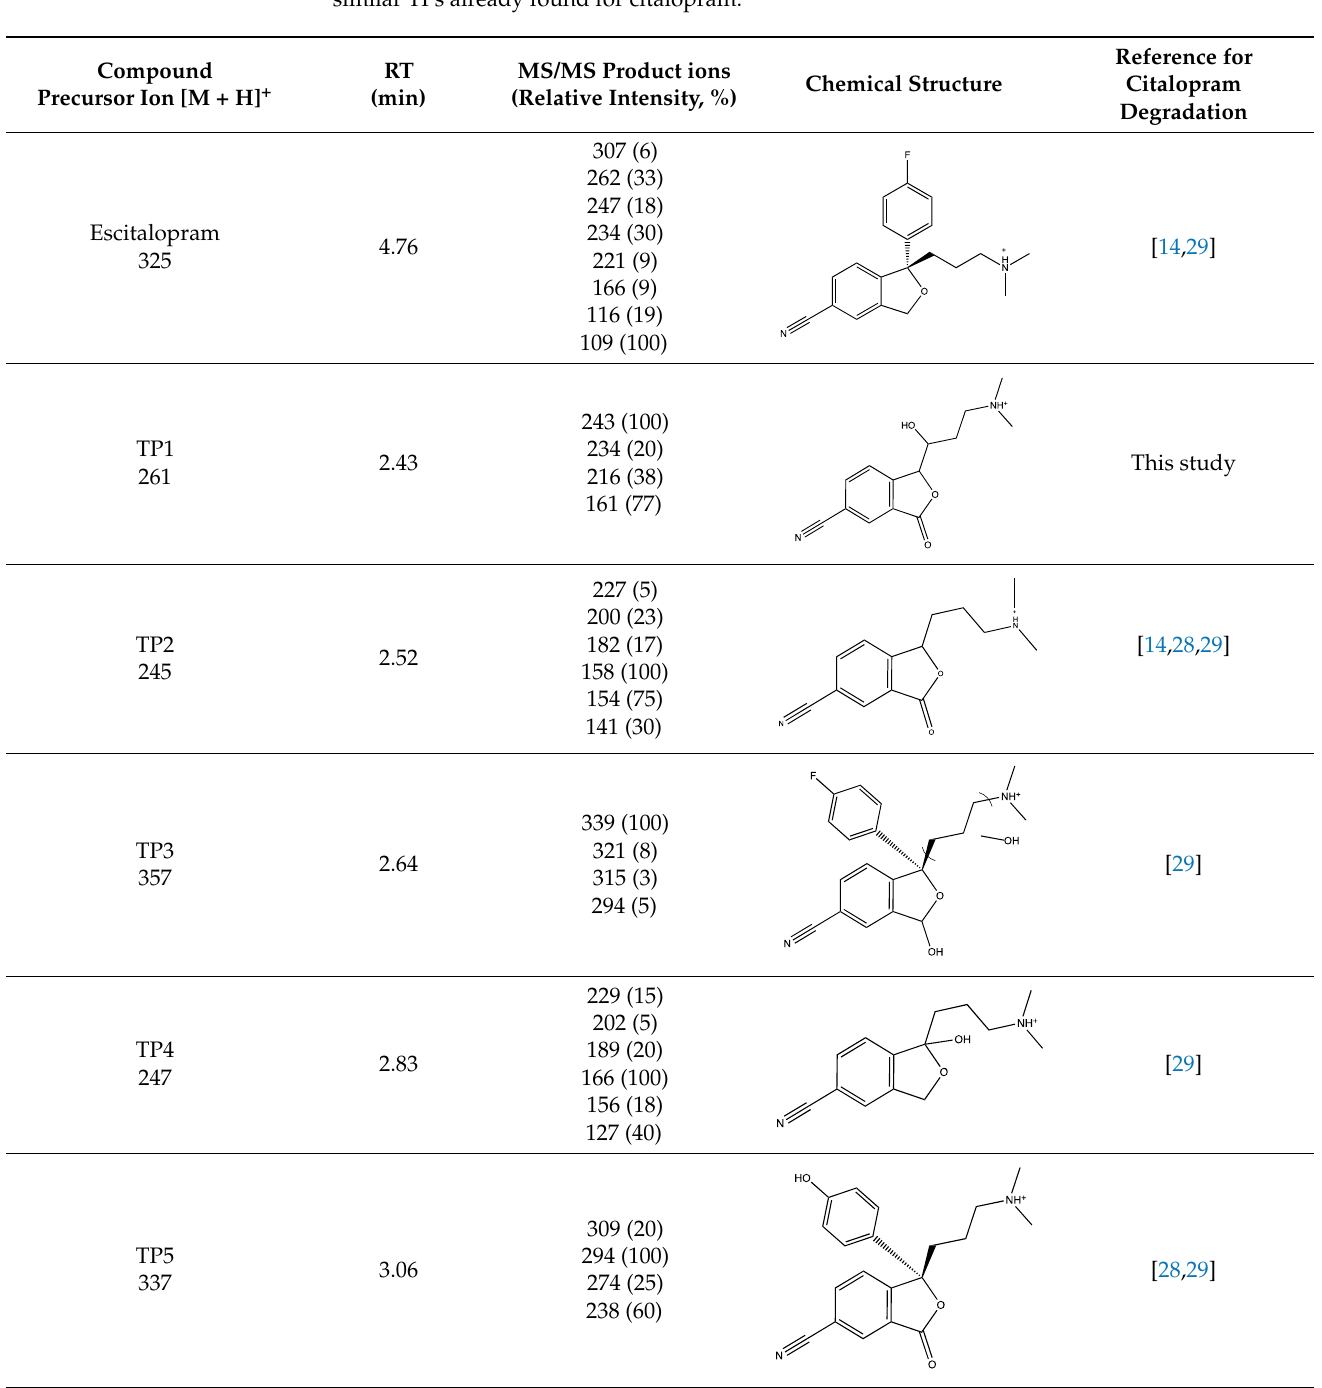
Table 2. TPs of ESC: retention time, precursor and most abundant product ions, and the references of similar TPs already found for citalopram.